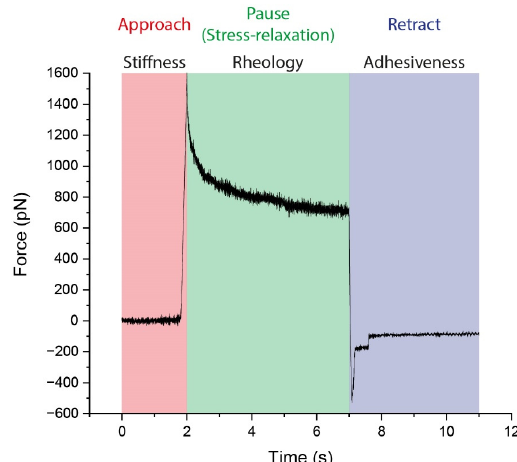
Figure 1. Force vs. time curve. Colored scheme showing the mechanical information derived from each of the different segments in one experiment: elastic modulus and stiffness (from the initial deformation and the slope, subsequently), stress relaxation (by fitting the decay obtained when fix- ing the Z position of the indenting tip during the pause time it is possible to elucidate the relaxation time), and adhesion-related factors (the minimum of the peak indicates the maximum adhesive force, and the integration of the area under the curve relates to the adhesion work). On the basis of these principles, previous collaborative work between our groups showed how nucleotide receptor regulation can influence the mechanical properties of cells at the nanoscale, as concluded from the studies performed on P2YR-expressing en- dothelial HUVEC cells and rat cerebellar astrocytes [26]. Stimulation of P2Y 2 Rs with UTP in both cell types caused an increase in cell stiffness and a decrease in adhesive properties. Further experiments with astrocytes showed that the effects of the purinergic agonist 2MeSADP on the mechanical properties of the cell were mediated by P2Y 13 receptors and negatively modulated by P2Y 1 receptors. As a logical continuation to those initial studies, and attending to what is described above, unravelling the role of P2X7 nucleotide recep- tors on the mechanical properties of rat cerebellar astrocytes becomes extremely interest- ing. Following this, in the present work, we show how stimulation of the P2X7 receptor of rat cerebellar astrocytes with the selective agonist BzATP specifically induced an in- crease in the cell size, motility, and number of membrane protrusions of the astrocytes in culture. Such effects were reverted when cells were treated with the competitive antago- nist of P2X7R, A 438079 (henceforth referred to as A43), prior to treatment with the agonist BzATP. Interestingly, when AFM was employed to further disentangle the role of P2X7 receptor in the modulation of the mechanical properties of this population on the na- noscale, an increase in the stiffness of the cells was observed. However, treatment with A43 did not effectively block such increase in stiffness caused by the agonist, pointing to the fact that the effects observed were not exclusively dependent on the ionotropic activity of the receptor but also on additional effects caused by independent metabotropic